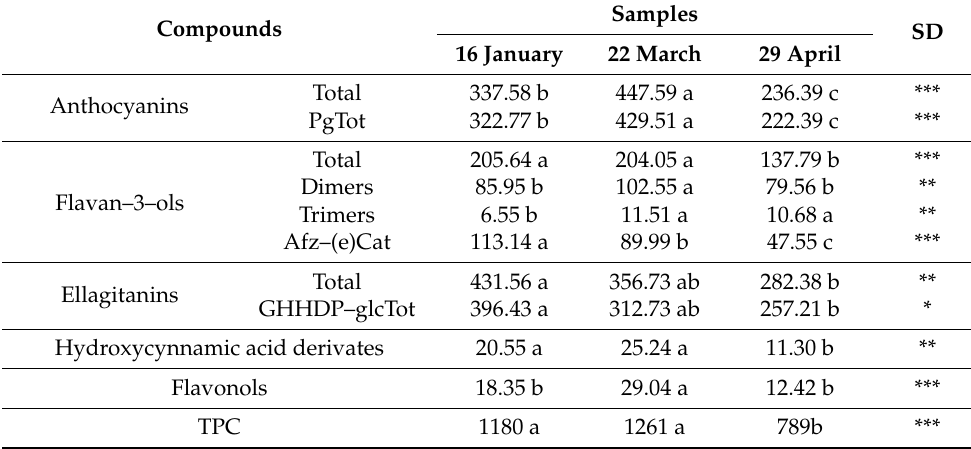
Table 4. Effects of temporal variations on the phenolic compounds evaluated in strawberry fruits. Concentrations are expressed in mg/100 g of dried weight a .